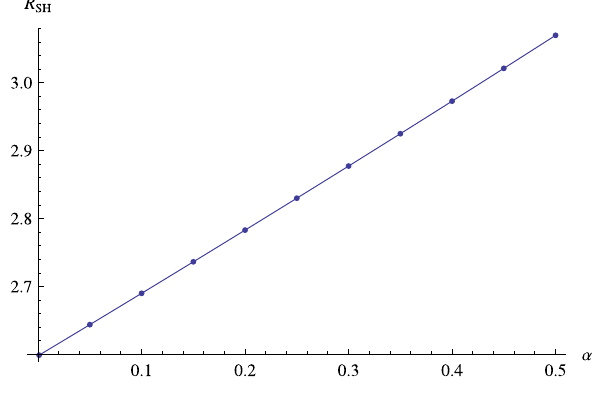
Fig. 6 Radius of the shadow as a function of α , r + =